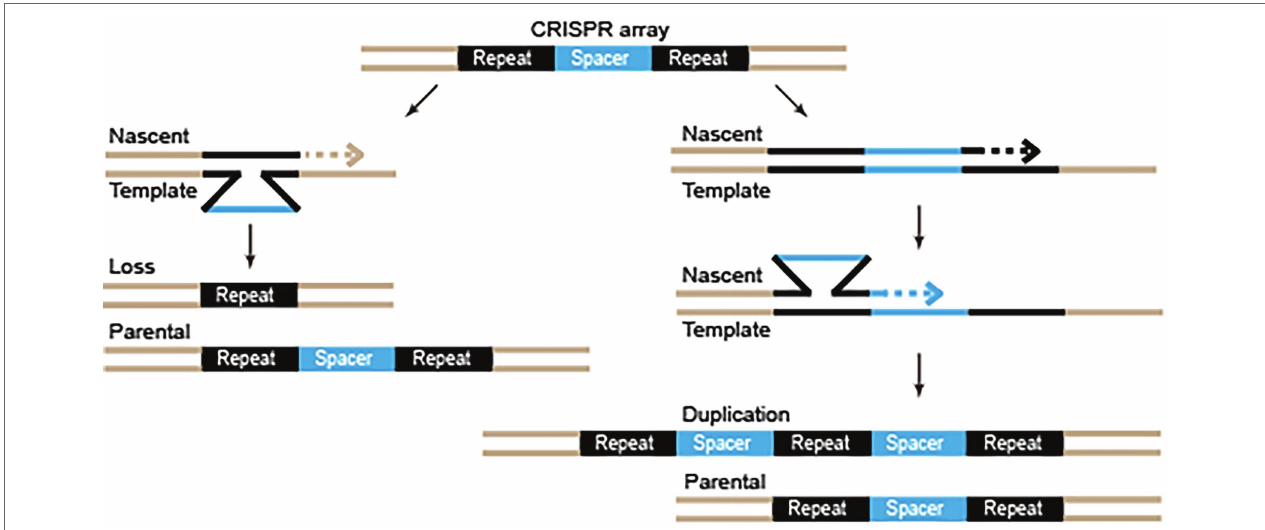
FIGURE 2 | Diagram of repeat-spacer loss and duplication by DNA replication slippage. Repeats and spacers are depicted by black and blue. Dashed arrows indicate the DNA synthesis